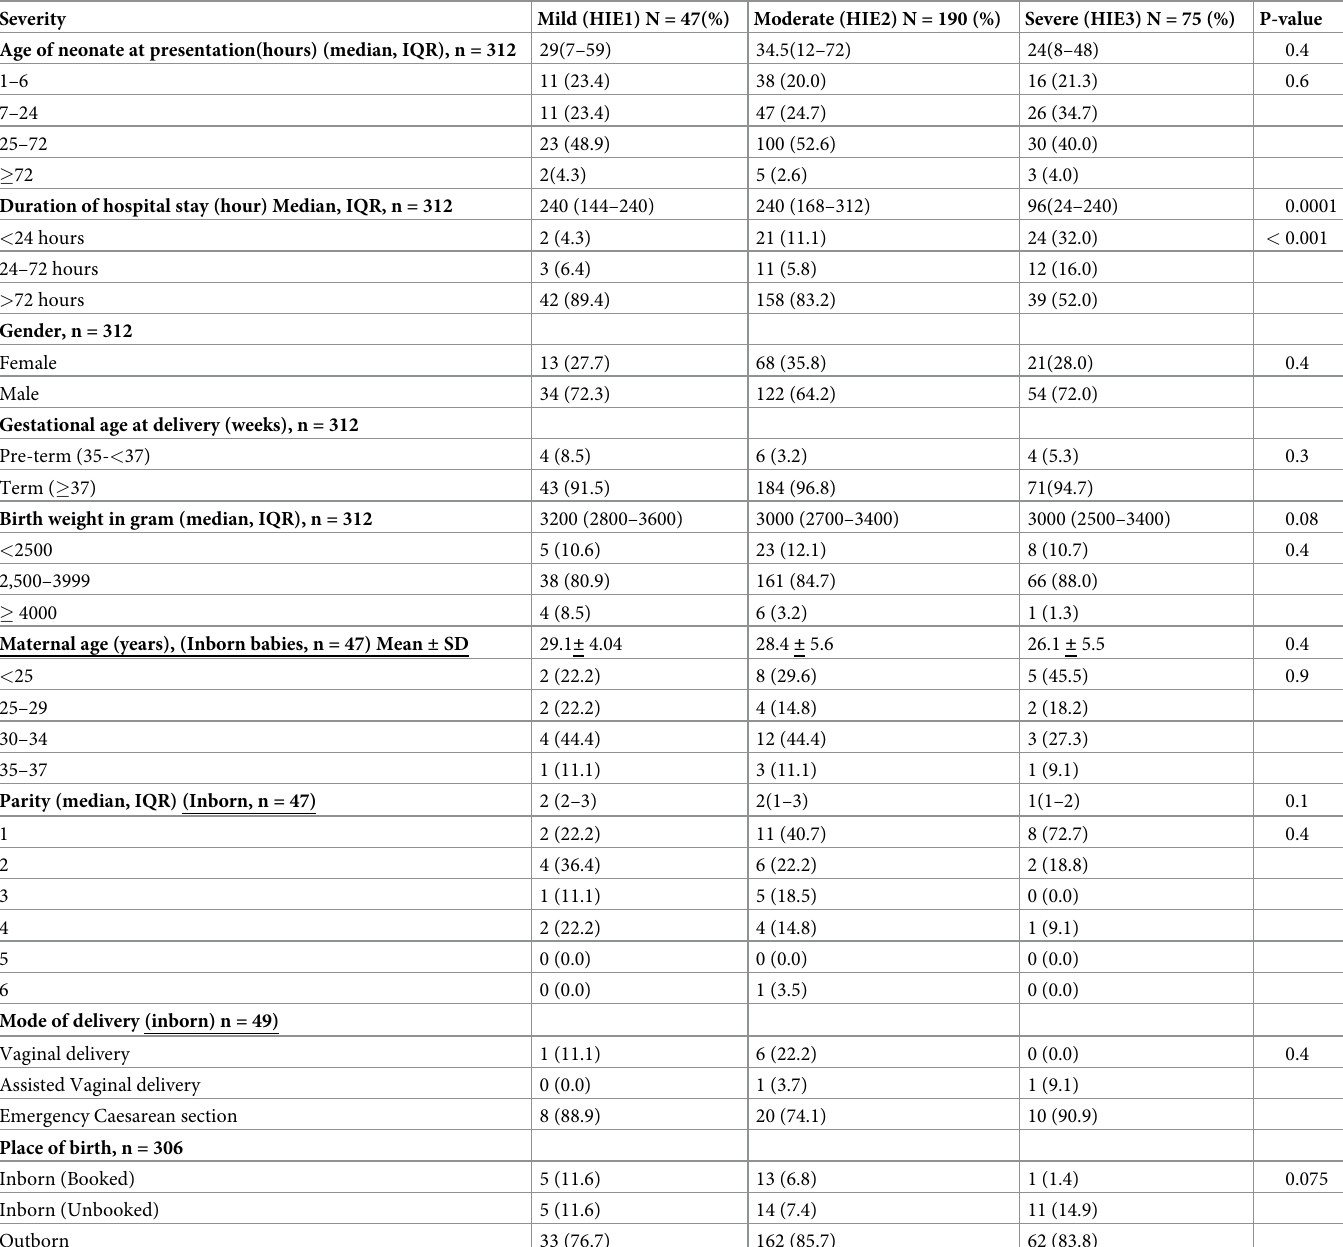
Table 4. Relationship between severity of HIE and neonatal and maternal factors.